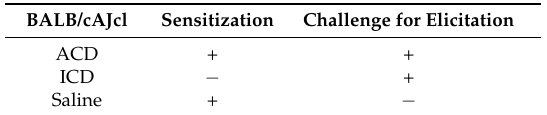
Table 1. Experimental groups of contact dermatitis to Pd-induced allergy.